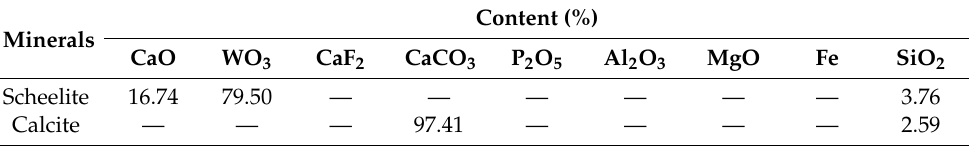
Table 1. Chemical composition analysis of the